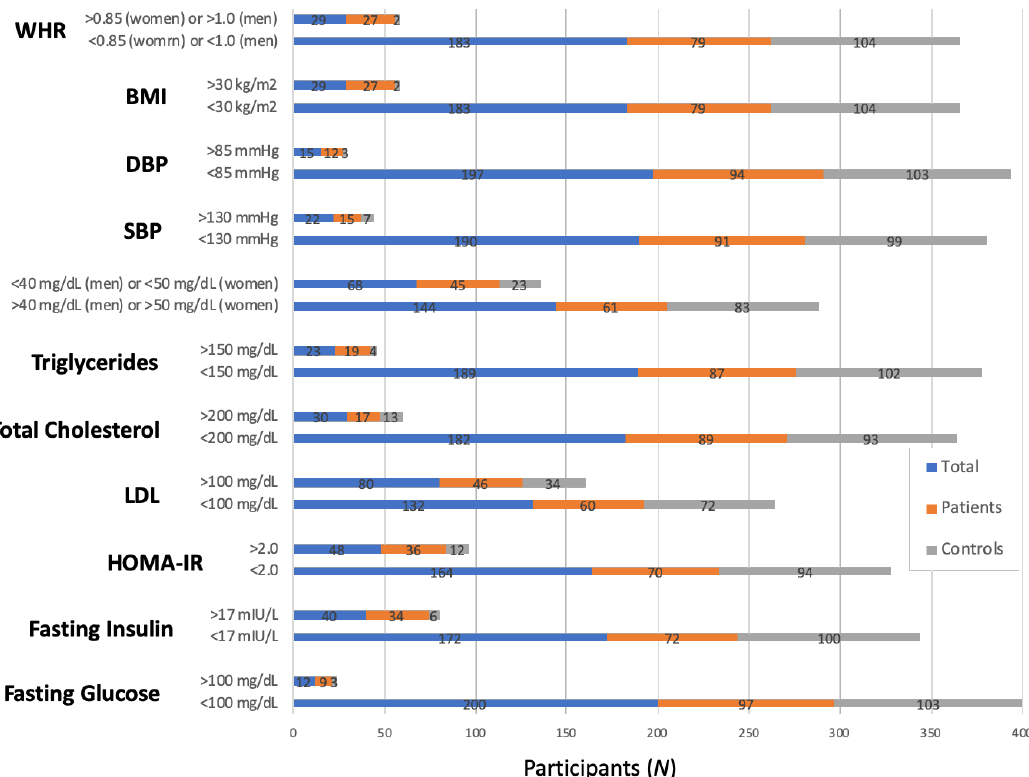
Figure 1. Variability in the Cardiometabolic Factors for the Total Sample, Patients with Major Depressive Disorder, and Student Control ( n = 212). Data are presented as the number of cardiometabolic abnormalities present for the total, patient, and control samples (top) and normal versus abnormal values for each cardiometabolic factor for the total, patient, and control samples (bottom). Factors are treated as independent, continuous determinants of metabolic health. Normal values for cardiometabolic factors were considered the following; BMI <30 kg/m 2 . SBP/DBP <130/<85 mmHg; fasting glucose <100 mg/dL; fasting insulin <17 mIU/L; total cholesterol <200 mg/dL; LDL-C <100 mg/dL; Triglycerides <150 mg/dL, HDL > 40 mg/dL (men) or >50 mg/dL (women); WHR <0.85 (women) or <1.0 (men); HOMA-IR (HOMA2) < 2.0. Abbr. BMI= body mass index. DBP = diastolic blood pressure. HDL-C= high density lipoprotein cholesterol. HOMA-IR= homeostatic assessment model of insulin resistance. LDL-C= low density lipoprotein cholesterol. SBP = systolic blood pressure. WHR = waist-to-hip ratio.